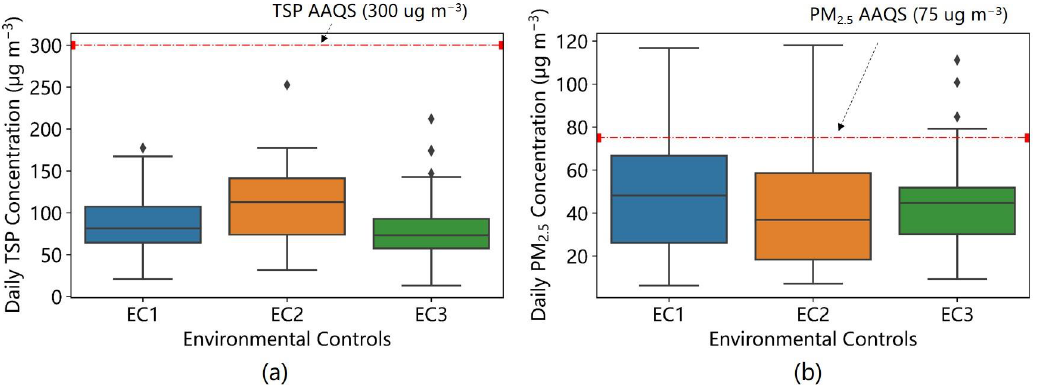
Figure 6. The daily mean TSP ( a ) and PM 2.5 ( b ) concentrations under three ECs; the red dotted lines representing thresholds of the second-level 24-h average TSP (300 μg m −3 ) and PM 2.5 (75 μg m −3 ) concentrations in the air regulated by AAQS of China standard. Rhombus presenting outliers.